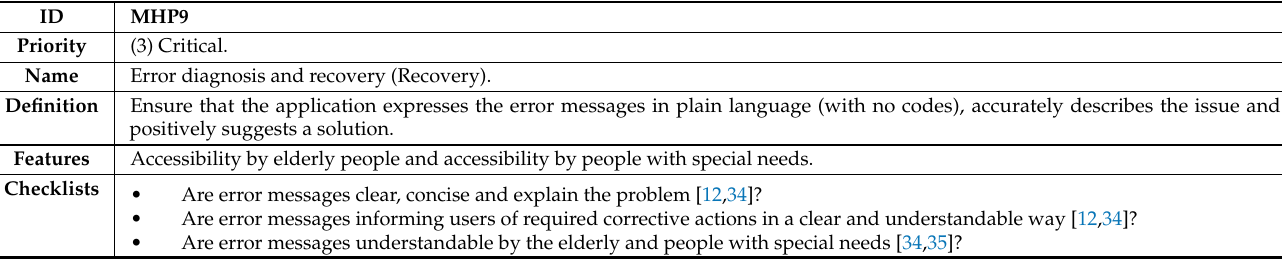
Table A9. Descriptive details of the ninth guideline.